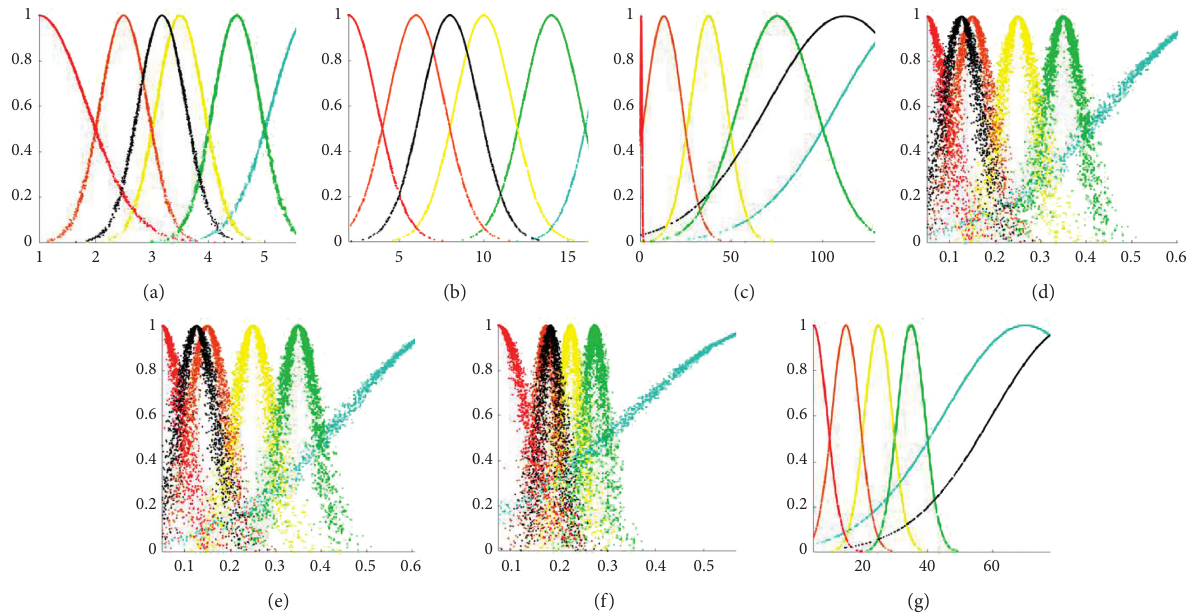
Figure 10: Cloud figures of social vulnerability (Blue for Level I, Green for Level II, Yellow for Level III, Brown for Level IV, Red for Level V, and Black for assessment value). (a) x 71 . (b) x 72 . (c) x 73 . (d) x 74 . (e) x 81 . (f) x 82 . (g) x 91 .